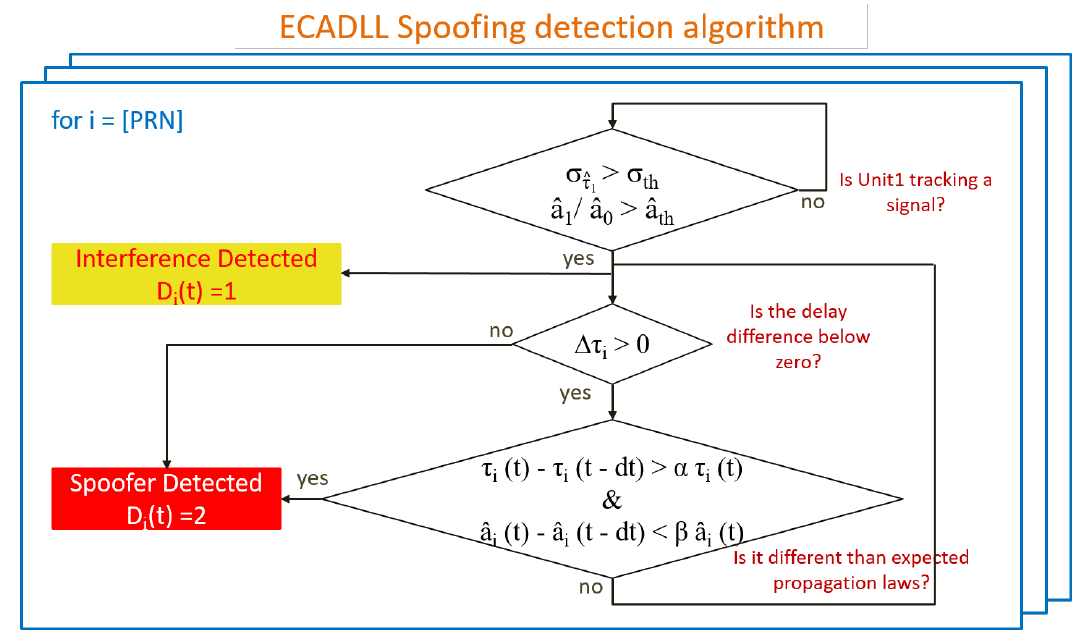
Figure 5. Figure of the proposed ECADLL algorithm. The procedure is repeated for all of the satellites, and it is able to classify the signal tracked by Unit1 as either impairment or